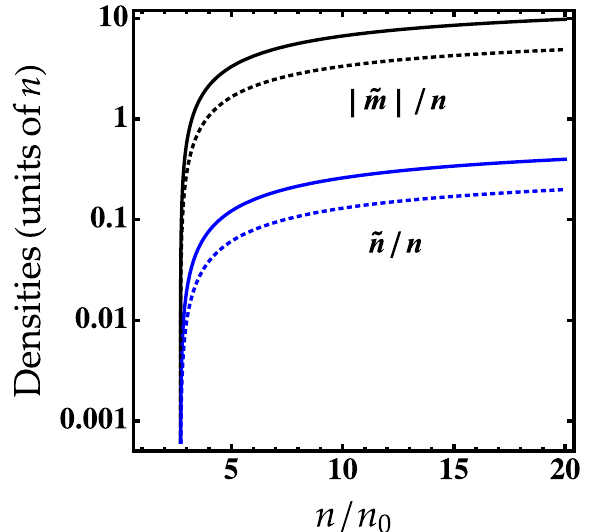
Figure 1. Noncondensed (11) and anomalous (12) fractions at the equilibrium as a function of n / n 0 for different values of ln ( a 12 / a ) . Solid lines: ln ( a 12 / a ) = 5 . Dotted lines: ln ( a 12 / a ) = 10